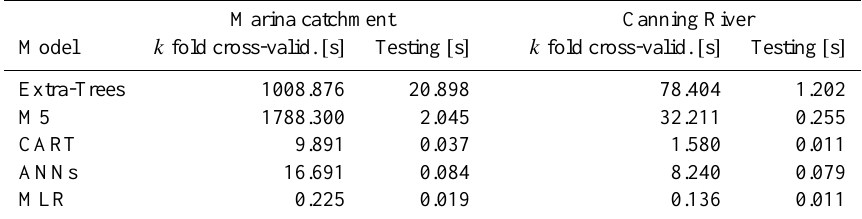
Table 10. Comparison of k fold cross-validation (with k =10) and testing CPU time for Extra-Trees, M5, CART, ANNs and MLR for Marina and Canning River dataset. The estimates are with respect to a single (of the 10) data group composing each